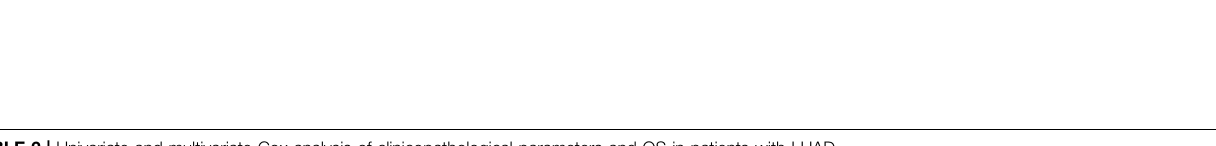
TABLE 2 | Univariate and multivariate Cox analysis of clinicopathological parameters and OS in patients with LUAD. Clinicopathologic